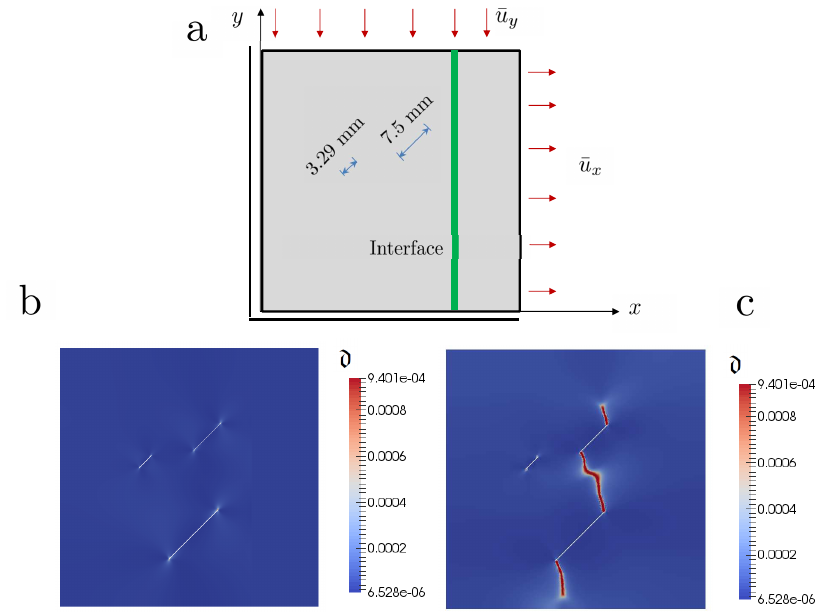
Figure 18. Specimen with 3 inclined flaws and a vertical interface: ( a ) Loading and geometric description. ( b ) Phase field pattern for ¯ u y = − 0.1 ¯ u x . ( c ) Phase field pattern for ¯ u y = − ¯ u x